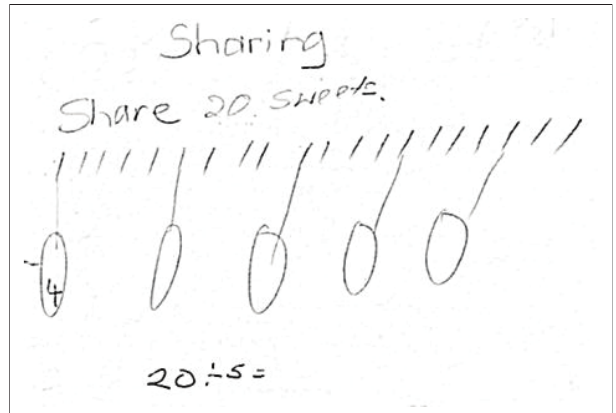
FIGURE 5: Teacher Norma’s drawing for share 20 sweets amongst five